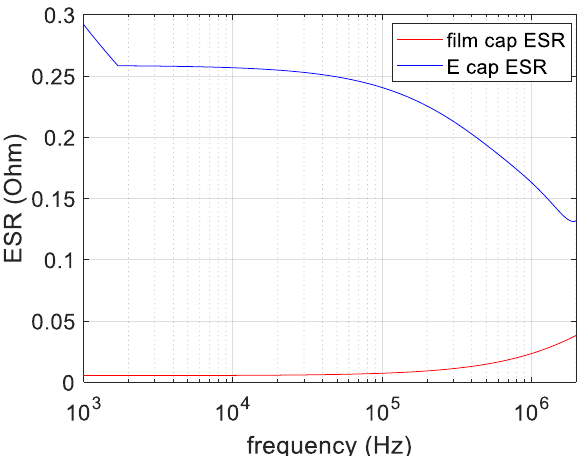
Figure 9. Frequency characteristics of ESR values of the electrolytic and film capacitors used in DC capacitor of VSI in electric compressor systems.